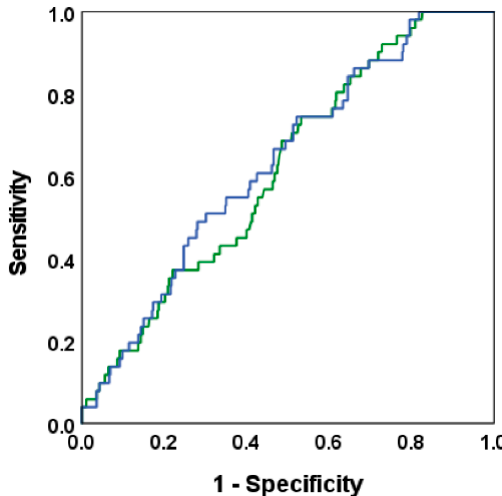
Figure 2. Receiver Operating Characteristic (ROC) curves represent two models to detect albuminuria: the first model (green line) with fasting plasma glucose and 1 h post-load glucose (area under the curve (AUC) 0.62; 95% CI 0.54–0.69), and the second model (blue line) with the first model plus 2 h post-load glucose (AUC 0.63; 95% CI 0.56–0.71, p = 0.21).